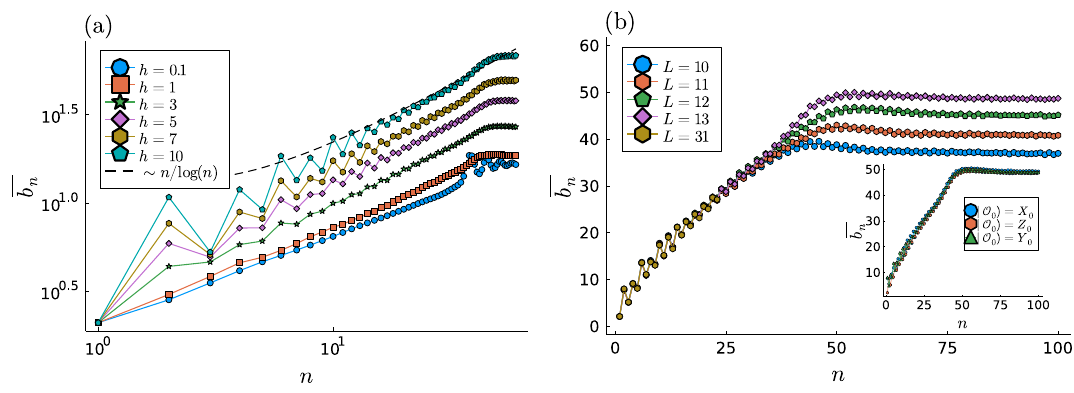
Figure 1: (a)The disorder-averaged Lanczos coefficients b for several disorder n strengths h and system size L = 13 in the random field Ising model, starting with the initial operator Z . In the MBL regime h (cid:166) 3, b has the same asymptotic behavior n 0 as in the ergodic regime, but with an additional even-odd alteration. (b)Disorder- averaged Lanczos coefficients b for several system sizes L and h = 7, with the initial n operator Z . The onset point of the plateau of b increases with the system size L . n 0 We therefore conclude that the saturation of b is due to the finite size. Inset: the dis- n order averaged Lanczos coefficients starting with the the X , Y and Z operators for 0 0 0 L = 13 and h = 7. The even-odd alteration of the Lanczos coefficients is independent of the choice of the initial